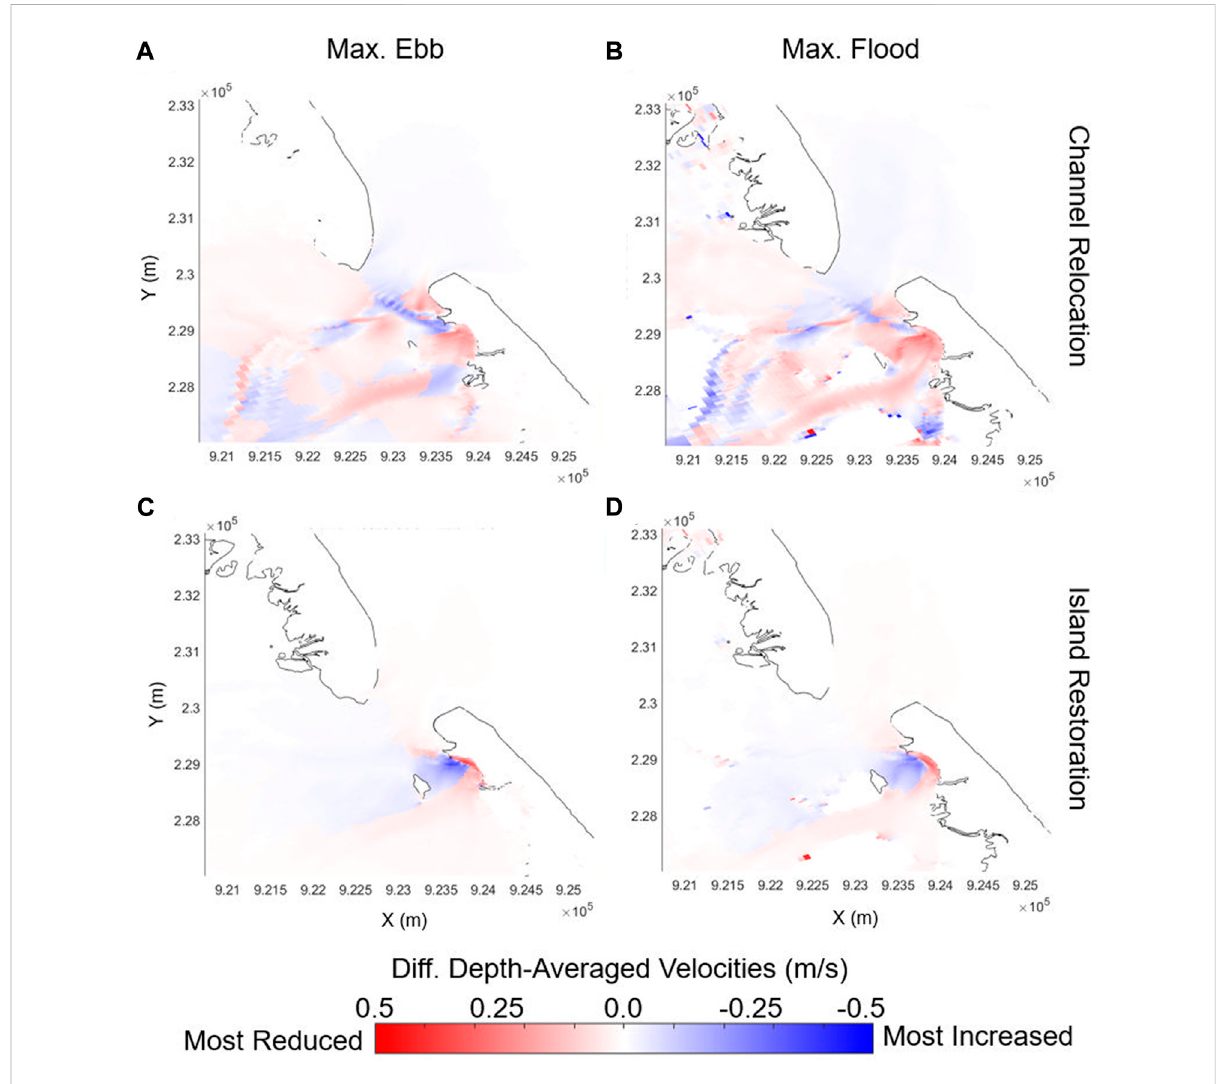
FIGURE 8 Difference in depth-averaged velocity for the present conditions and for the (A,B) channel relocation and (C,D) island restoration during (A,C) maximum ebb and (B,D) maximum fl ood. Red and blue colors indicate reduced and increased velocity, respectively, relative to present